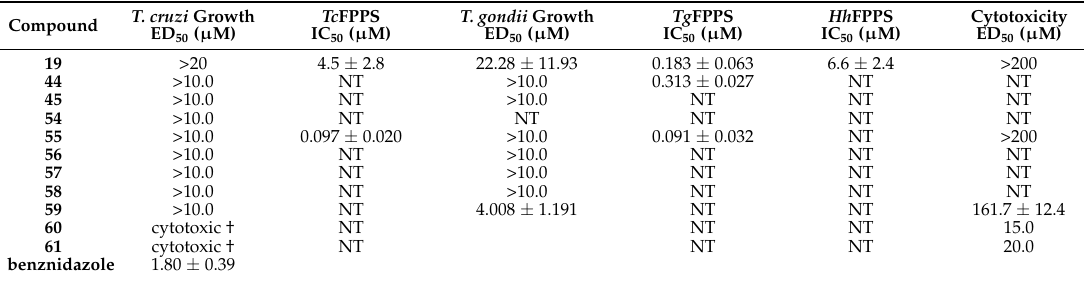
Table 2. Biological activity of bisphosphonates against T. cruzi (amastigotes), T. gondii (tachyzoites), Tc FPPS, Tg FPPS, human FPPS ( Hh FPPS) and Vero cells ‡ .